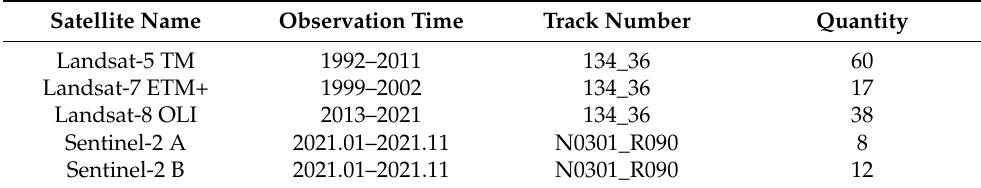
Table 2. Summary of Landsat Series and Sentinel-2 Image Data in Ngoring